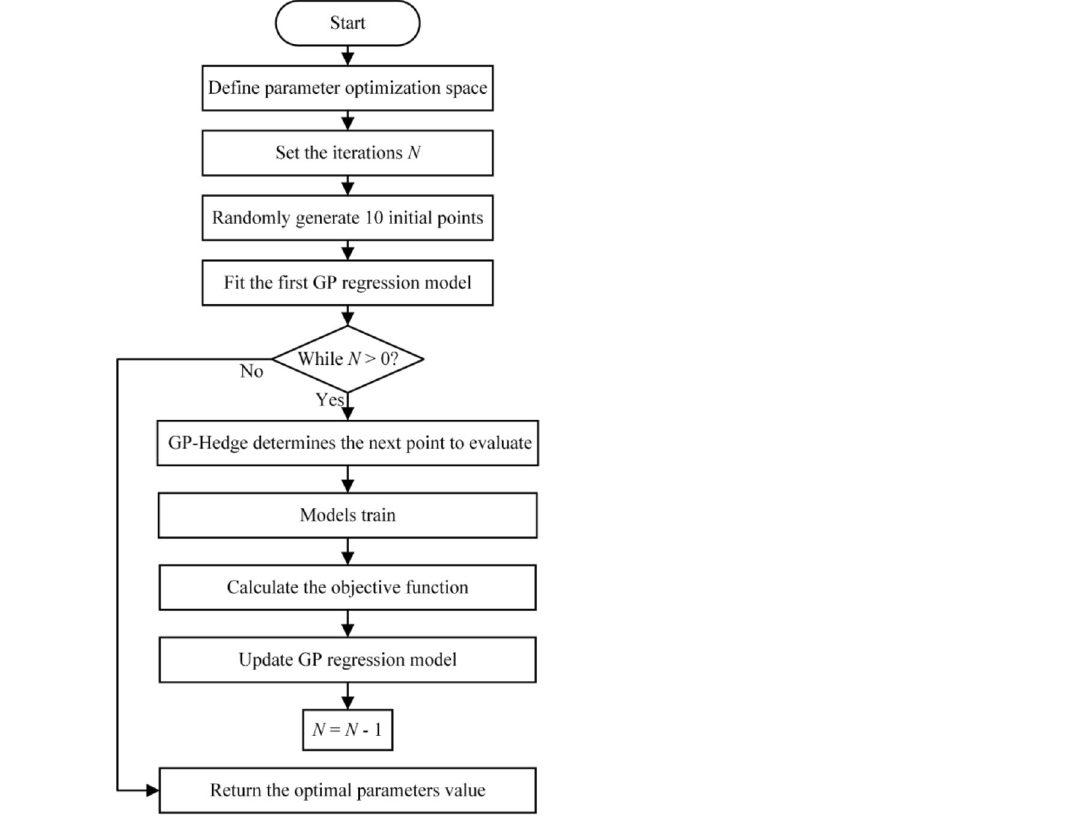
Figure 6. The Bayesian optimization flow